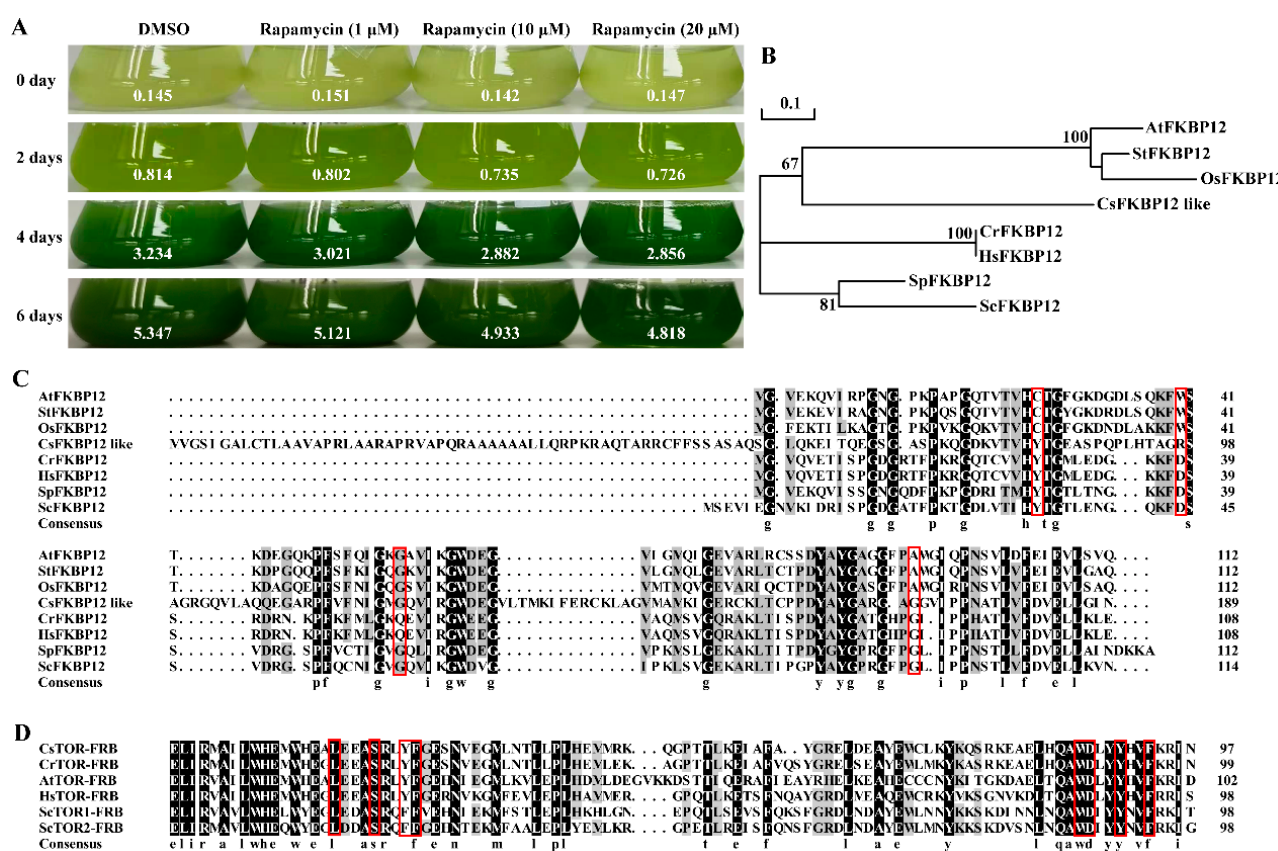
Figure 3. Chlorella sorokiniana cells are insensitive to rapamycin. ( A ) Phenotype of Chlorella sorokiniana DP-1 treated with different concentrations of rapamycin for 0, 2, 4 and 6 days. The values represent the corresponding OD680nm values. ( B ) Phylogenetic tree analysis of FKBP12 protein sequences from Chlorella sorokiniana and other species. Phylogenetic tree generated from the neighbor-joining method (used MEGA 4 software, 1000 of bootstrap replicates) based on TOR protein sequences. Chlorella sorokiniana (Cs), Chlamydomonas reinhardtii (Cr), Arabidopsis thaliana (At), Homo sapiens (Hs), Saccharomyces cerevisiae (Sc), Schizosaccharomyces pombe (Sp), Oryza sativa (Os), Solanum tuberosum (St). ( C ) Sequence alignment analysis of CsFKBP12 protein with that from other species. The red box represents the conserved amino acid of the FKBP12 binding to rapamycin. ( D ) Sequence alignment analysis of the FRB domain of CsTOR protein with that from other species. The red box represents the conserved amino acid of the FRB domain binding to rapamycin.